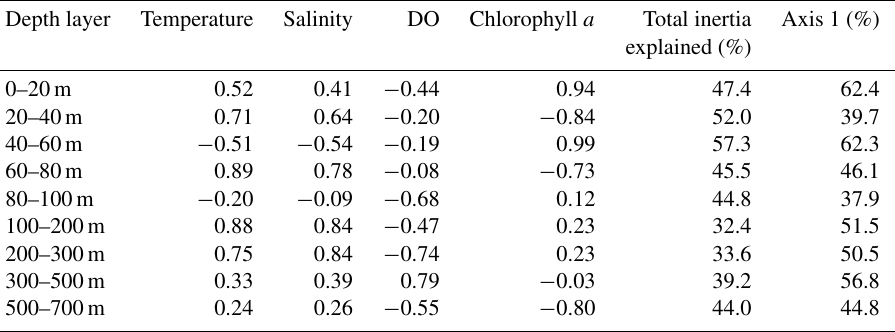
Table 4. Depth-resolved CCA results, including the loadings of the four tested environmental parameters on the first canonical axis, the total proportion of inertia in the faunal composition explained by the constrained ordination, and the proportion of constrained inertia explained by the first CCA